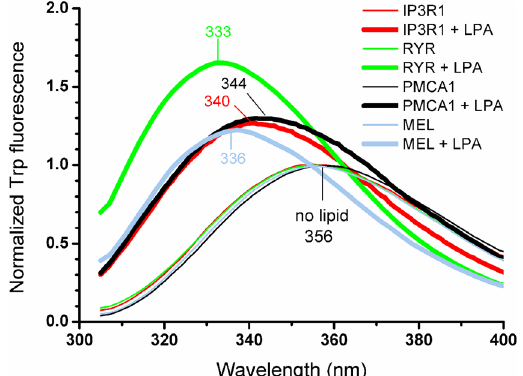
Figure 2. Lipid-peptide interactions studied by tryptophan (Trp) fluorescence. Spectra were taken at peptide concentration of 3 μ M with and without 100 μ M LPA in high-salt buffer, and normalized pairwise to the maximal intensity (I max ) measured in the absence of the lipid. Note that each peptide alone showed emission maximum at 356 nm resulting in overlapping spectra which blue-shifted upon LPA addition as labelled in the figure, and listed in Table 2. Emission intensity variations at 1, 3, 6, and 10 μ M are compared in Fig. S2.